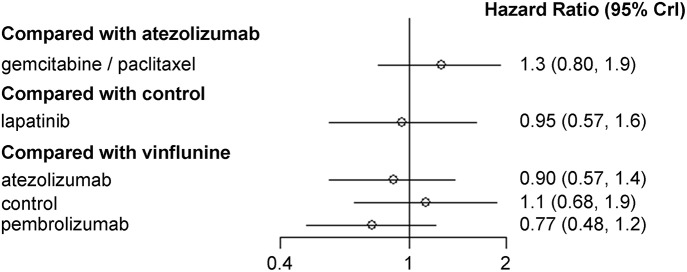
Pooled hazard ratio and 95% credible intervals for network meta-analysis of the impact of each second-line therapeutic agent on overall survival.